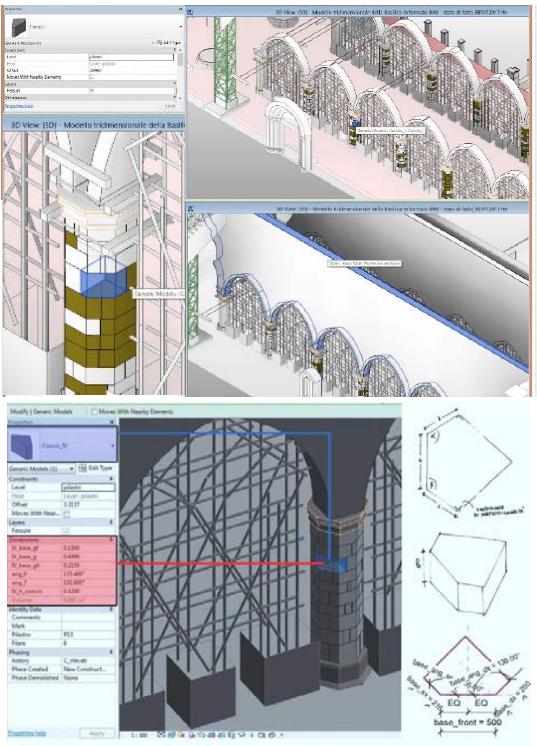
Figure 7. HBIM model of the arches and the octagonal stone pillars (above). Pillar n. 6 of the nave (bottom): on the right the hands-on survey of the only completely visible ashlar element.